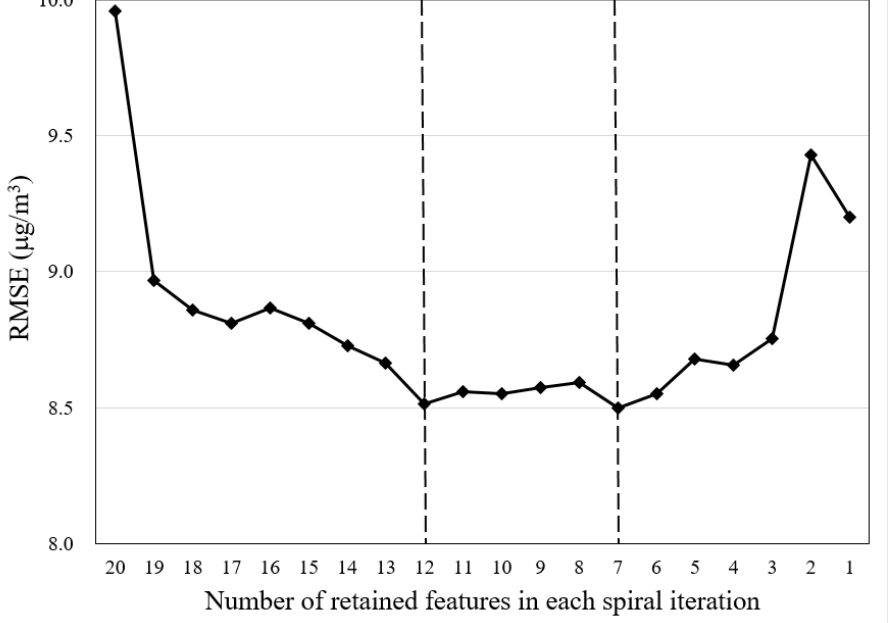
Figure 5. Variations of forecasting RMSE with the retained feature set in each spiral iteration.